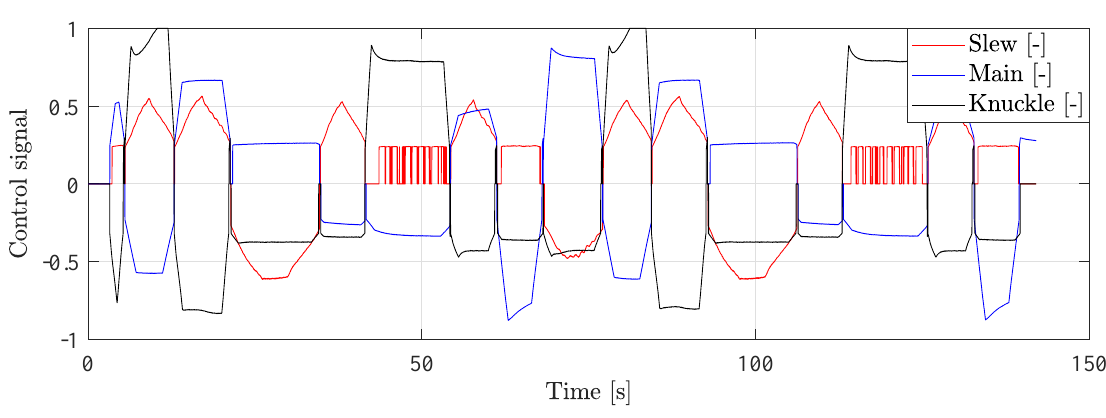
Figure 16. Control signal from laboratory test.